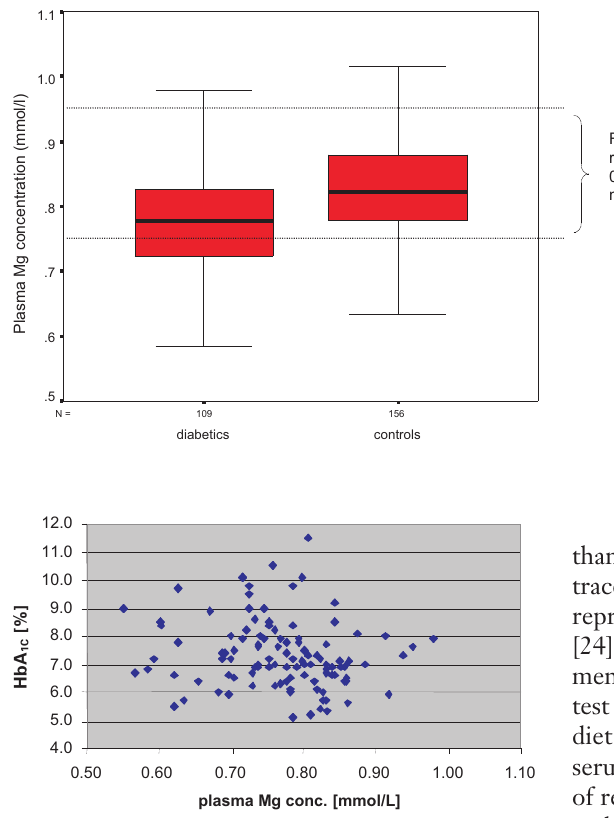
Figure 1 Plasma Mg concen- trations of type 2 dia- betics and controls. Box-whiskers plot showing medians, first and third quar- tiles, and minima and maxima.